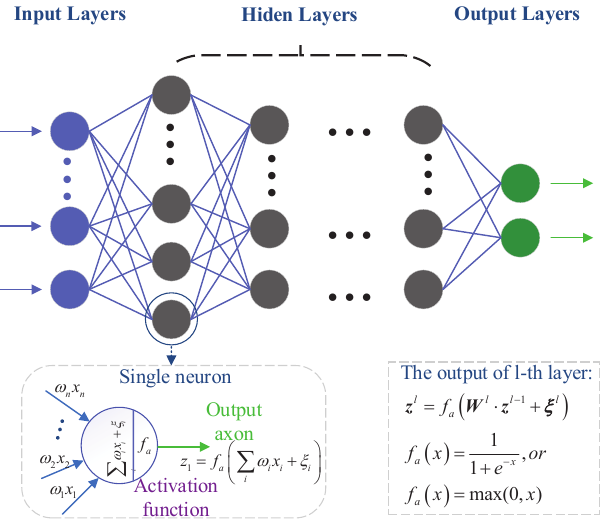
Figure 1. The deep neural